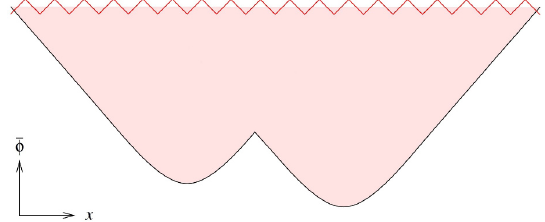
Figure 5. IFS merger is one of the channels that determines τ IFS